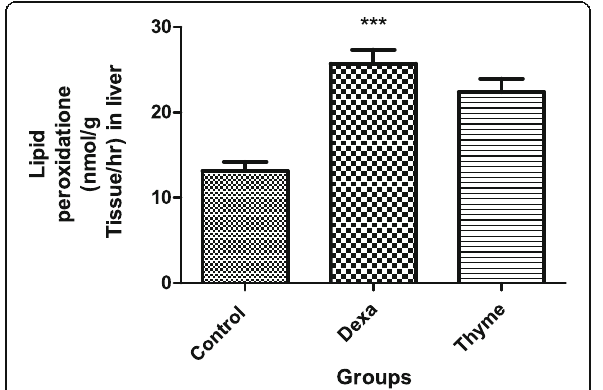
Fig. 5 The defensive role of thyme aqueous extract on liver lipid peroxidation level in normal and dexamethasone (DXM)-treated rats. Percentage changes (%) were calculated by comparing normal group with DXM-treated group and pre-treated DXM groups with DXM-treated group